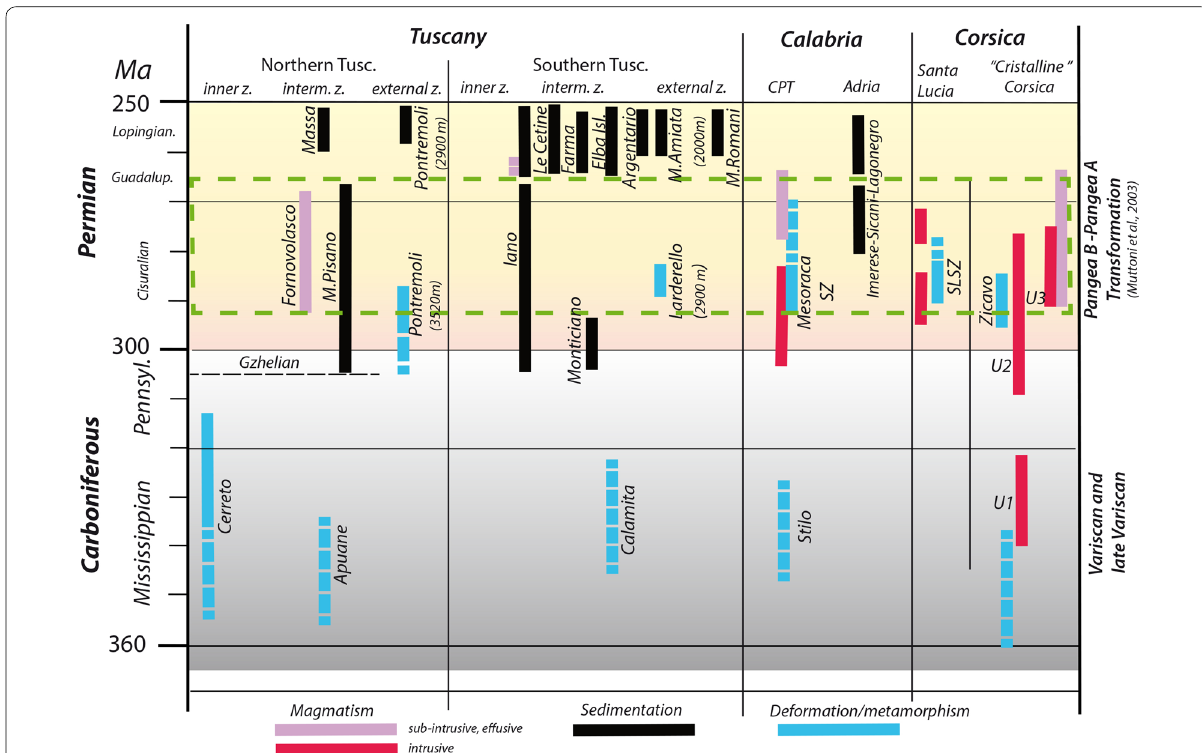
Fig. 13 A summary of the age data of sedimentary, magmatic and tectonic events in late Palaeozoic record in Tuscany, Calabria and Corsica (Santa Lucia and Crystalline Corsica). Red bars refer to ages in intrusive mainly granitic rocks; whereas in pink subintrusive to effusive magmatic rocks, bluish bars refer to deformation and metamorphic ages, and black lines denotes the range of sedimentation as deduced from paleontological data. Sources of data are reported in text and